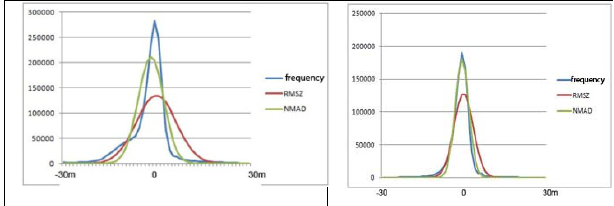
Figure 3: frequency distribution SRTM DSM Pennsylvania against reference DTM, left: whole area, right: only open area